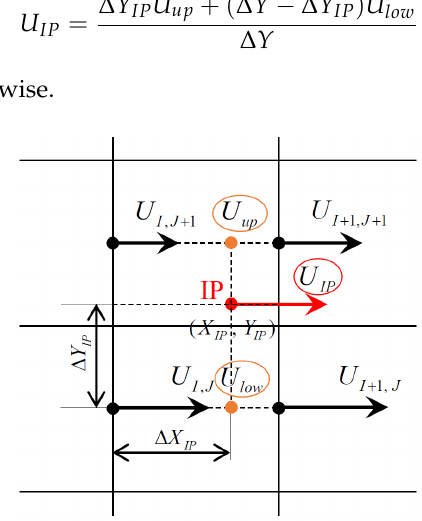
Figure 7. Schematic of how to calculate U IP